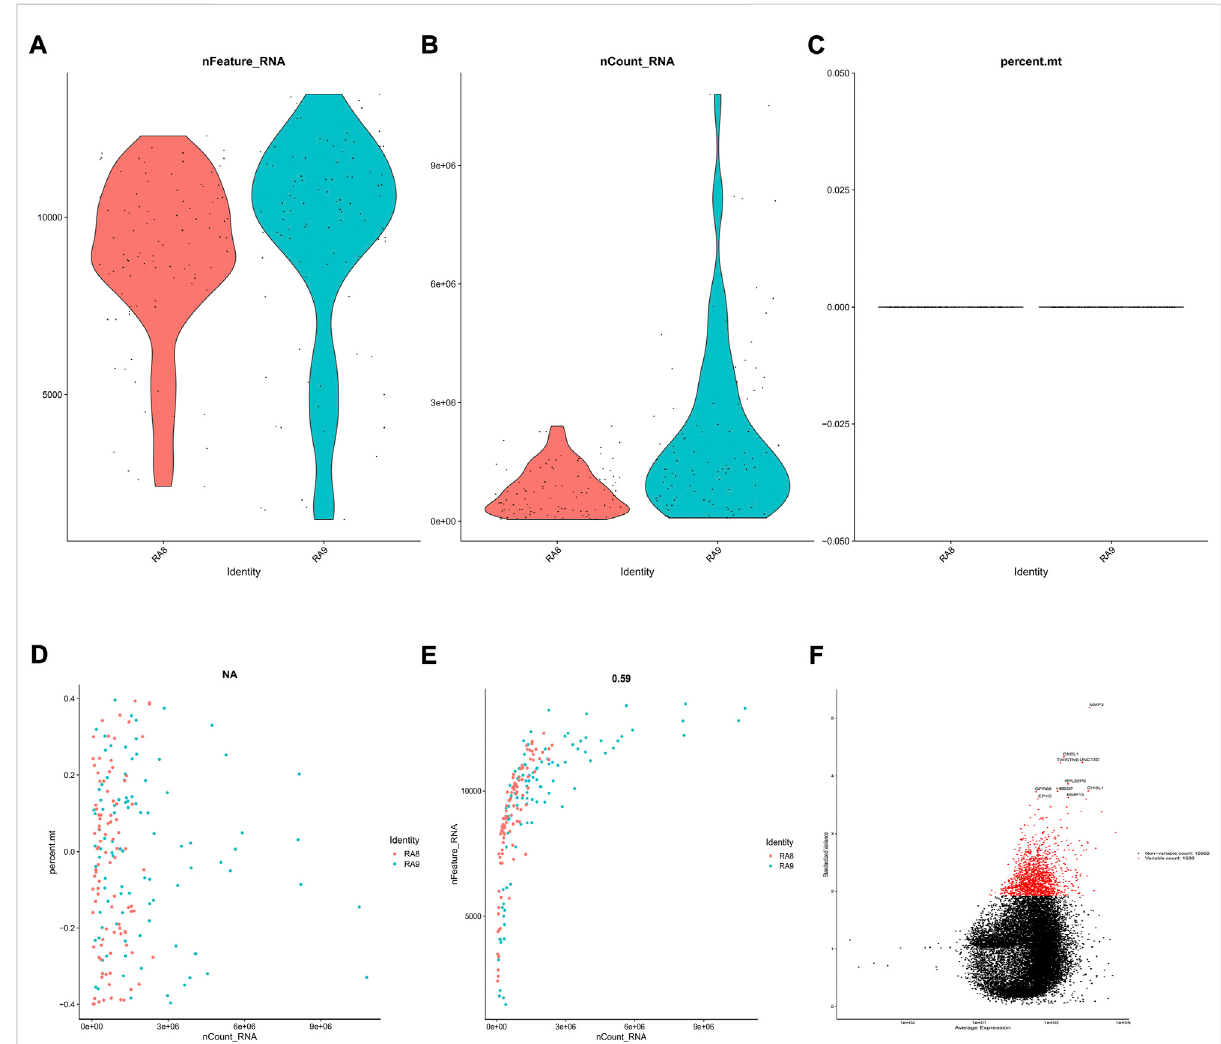
Evaluation of SFs ’ scRNA-seq results. GSE109449 provided access to scRNA-seq datasets for 192 SFs obtained from two RA cases (RA8 and RA9),followedbyevaluationinthreeaspectsincluding (A) nFeature (B) nCount, and (C) percent.mt,asdepictedwithinviolin-plots.Next,correlation analyses were conducted on (D) nCount, percent. mt and (E) nCount and nFeature, and (F) Genes with greater expression changes in various cells were investigated using a scatter diagram. The vertical axis represents standardized variance, the abscissa represents average expression, and the red and black pots represent the top 1,000 and lower 1,000 genes,